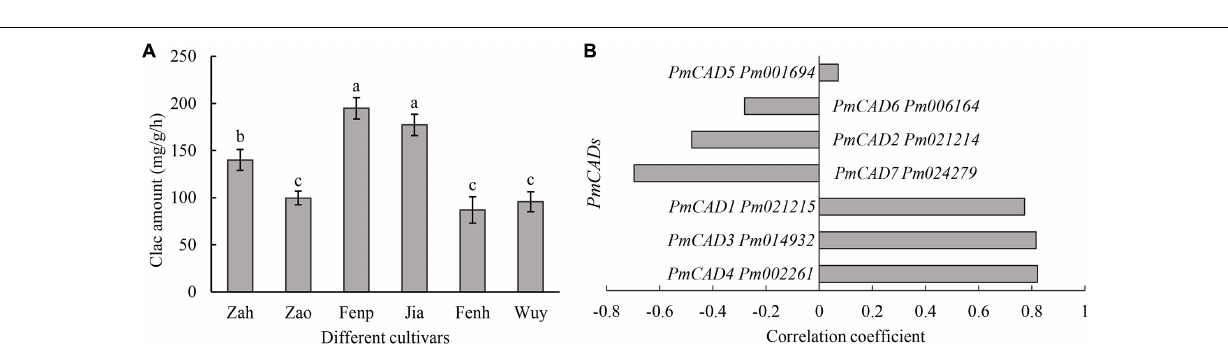
FIGURE 4 | Screening of key PmCADs via enzyme activity and correlation analyses. (A) Enzyme activities that cinnamaldehyde to product cinnamyl alcohol of different P. mume cultivars. Calc: cinnamyl alcohol. The value represents the mean of three samples, and SD is also performed with three replicates. The lowercase letters represent the significant differences ( p < 0.05). (B) Correlation analysis between enzyme activity and gene expression of PmCADs in six P. mume